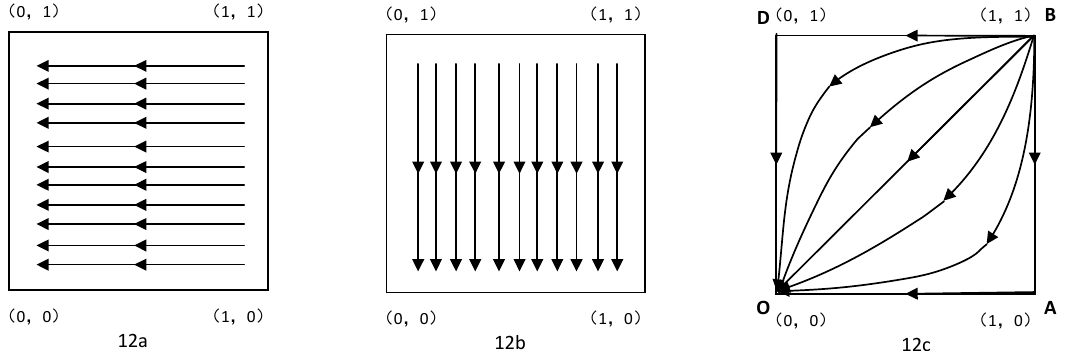
Figure 12. Analysis of the evolution process in Case 4. ( a ) Power grid companies; ( b ) users; and ( c ) power grid companies and users.